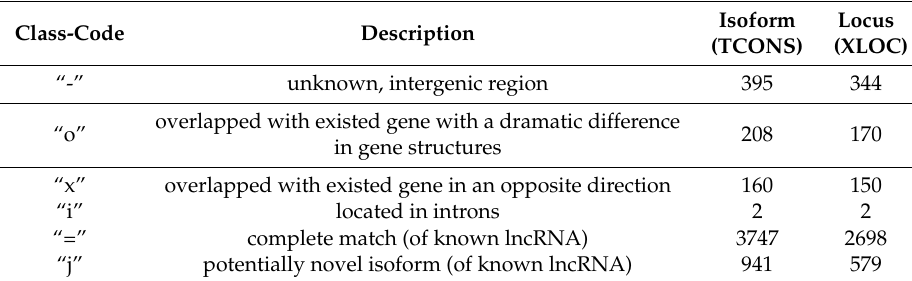
Table 1. Classification of 5453 lncRNA transcripts (class code module in